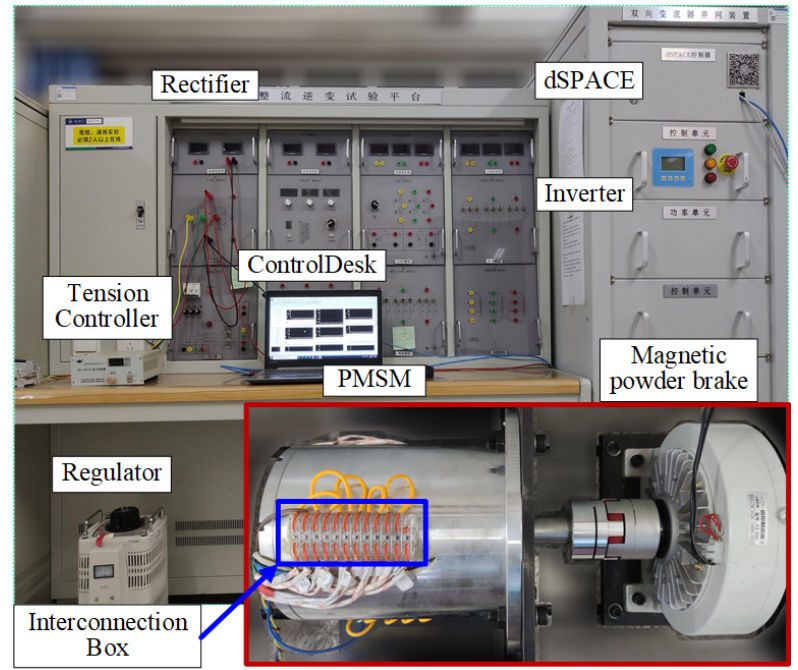
Figure 8. Experimental setup for ITSCs detection.